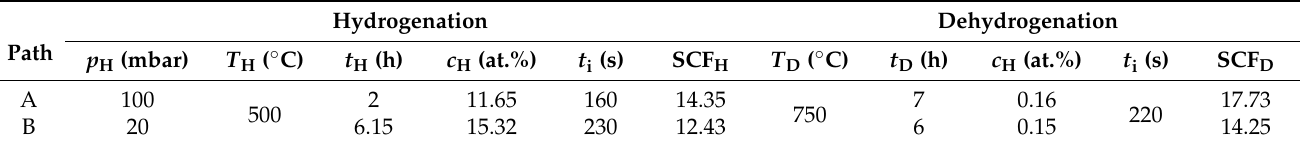
Table 5. Overview of the parameters used and calculated for THT.